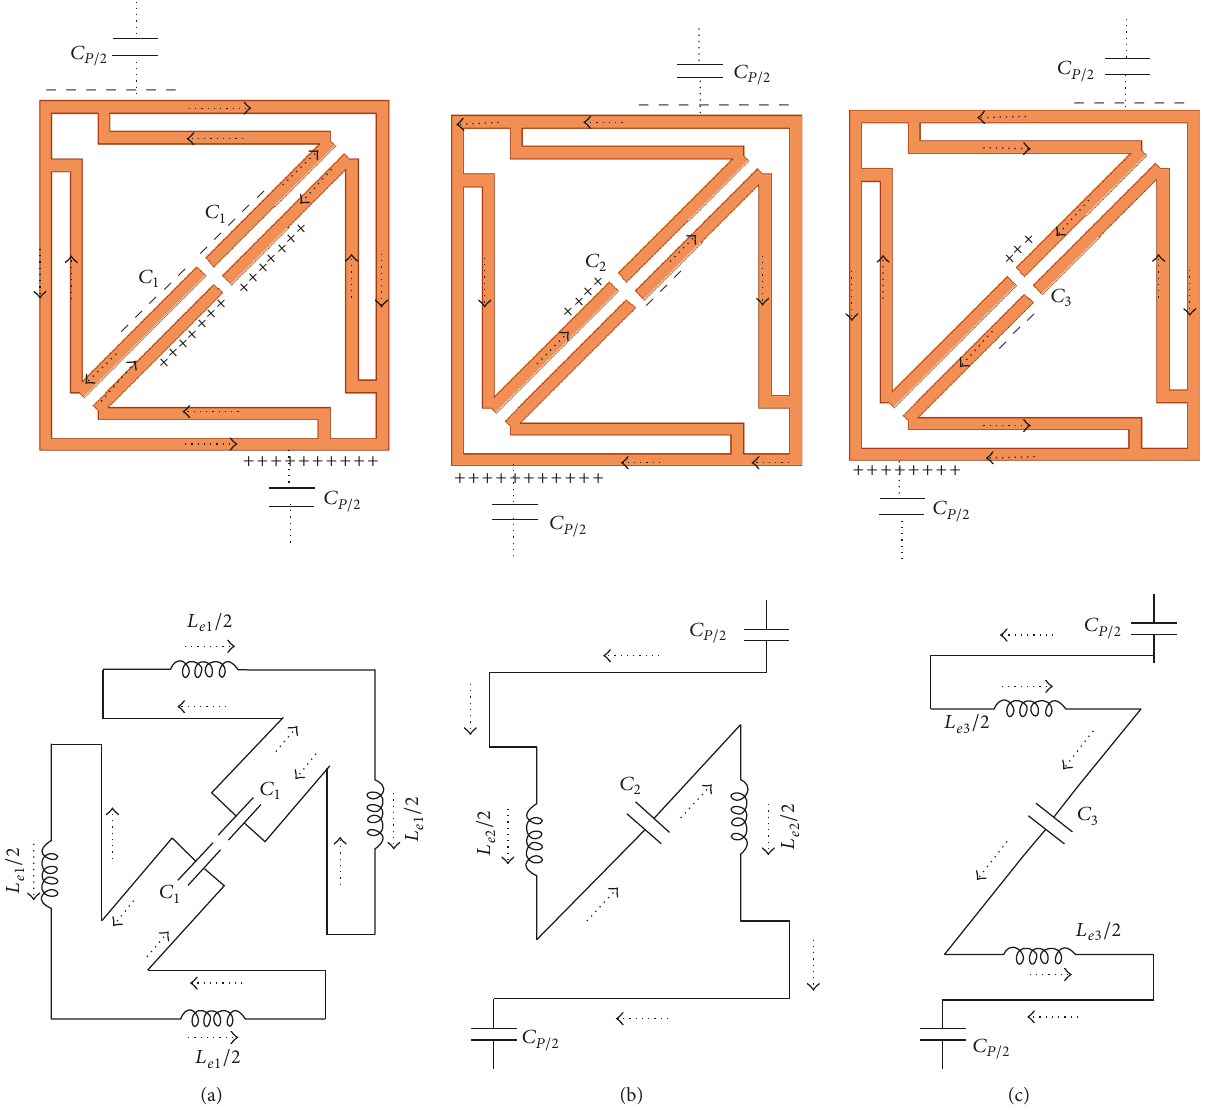
Figure 7: Equivalent circuit topology for geometry of TBEMR at resonant frequencies (a) 𝑓 01 = 4.32 GHz, (b) 𝑓 02 = 7.55 GHz, and (c) 𝑓 = 9.76 GHz. Current flow is represented by dashed arrow and capacitances are denoted by 𝐶 03